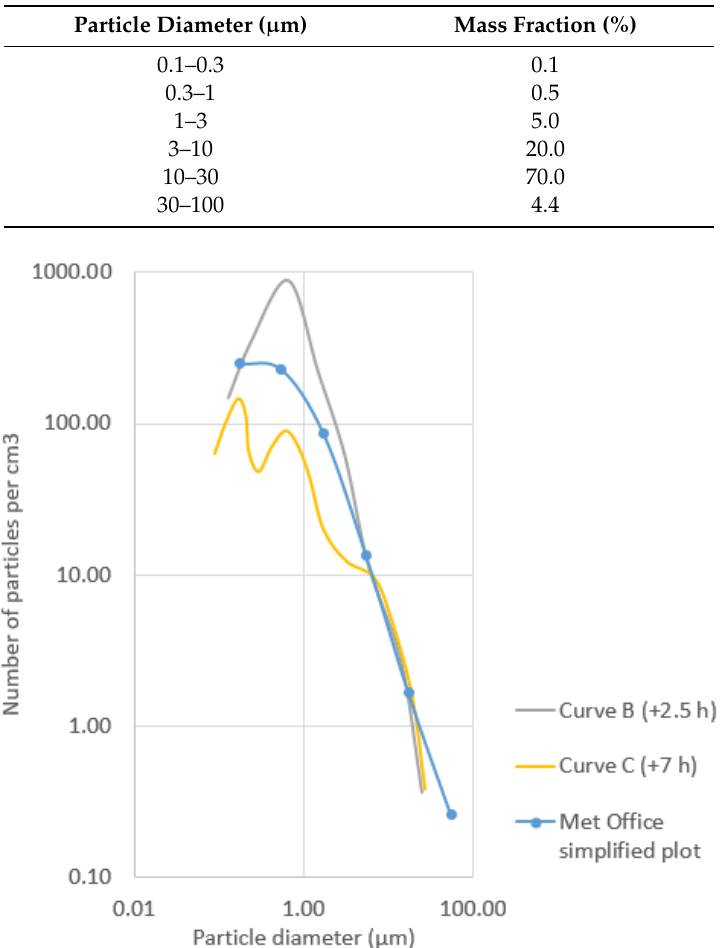
Table 3. Default particle size distribution (equivalent sphere diameters) used by the London Volcanic Ash Advisory Centre (VAAC) for forecasting ash dispersion.